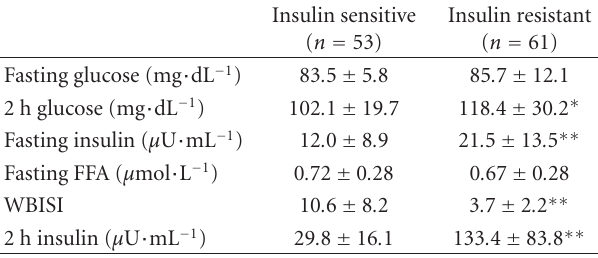
Table 2: Metabolic response characteristics to the OGTT.